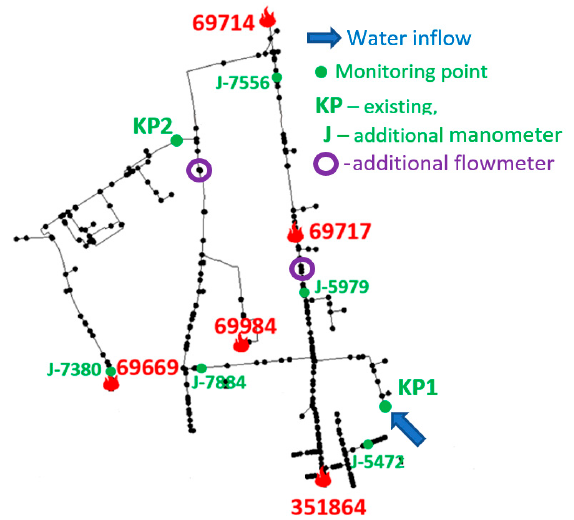
Figure 6. Location of the additional pressure manometers and flow meters.